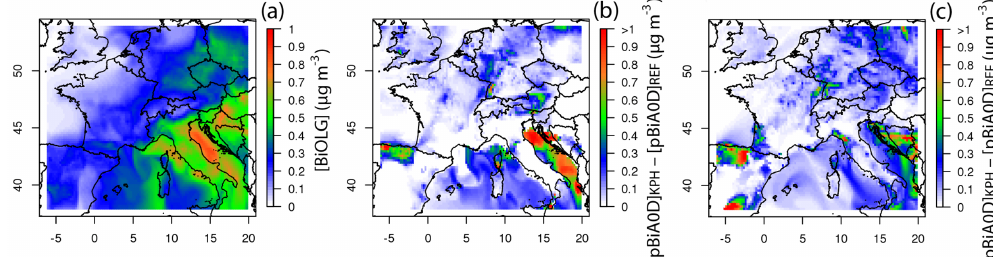
Figure 4. Oligomer daily maxima modeled with the two modeling approaches, using three different CHIMERE configurations for oligomer formation: KIN (a) , KPH deliquescent (b) and KPH metastable (c) for 24 July